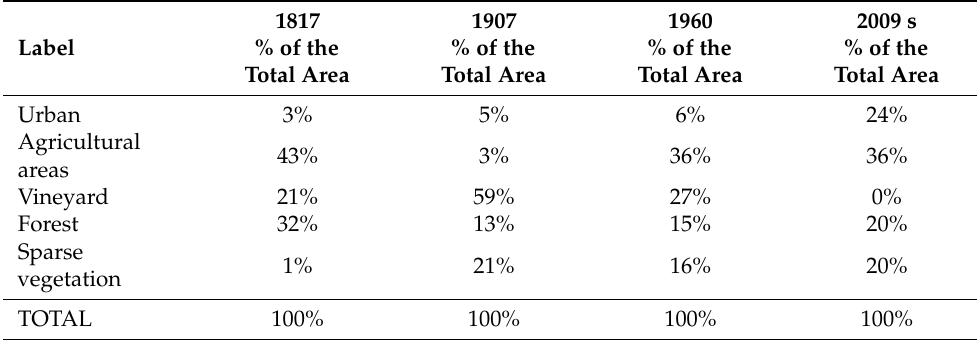
Table 3. Percentage of land cover classes of the total study area for the different time steps.